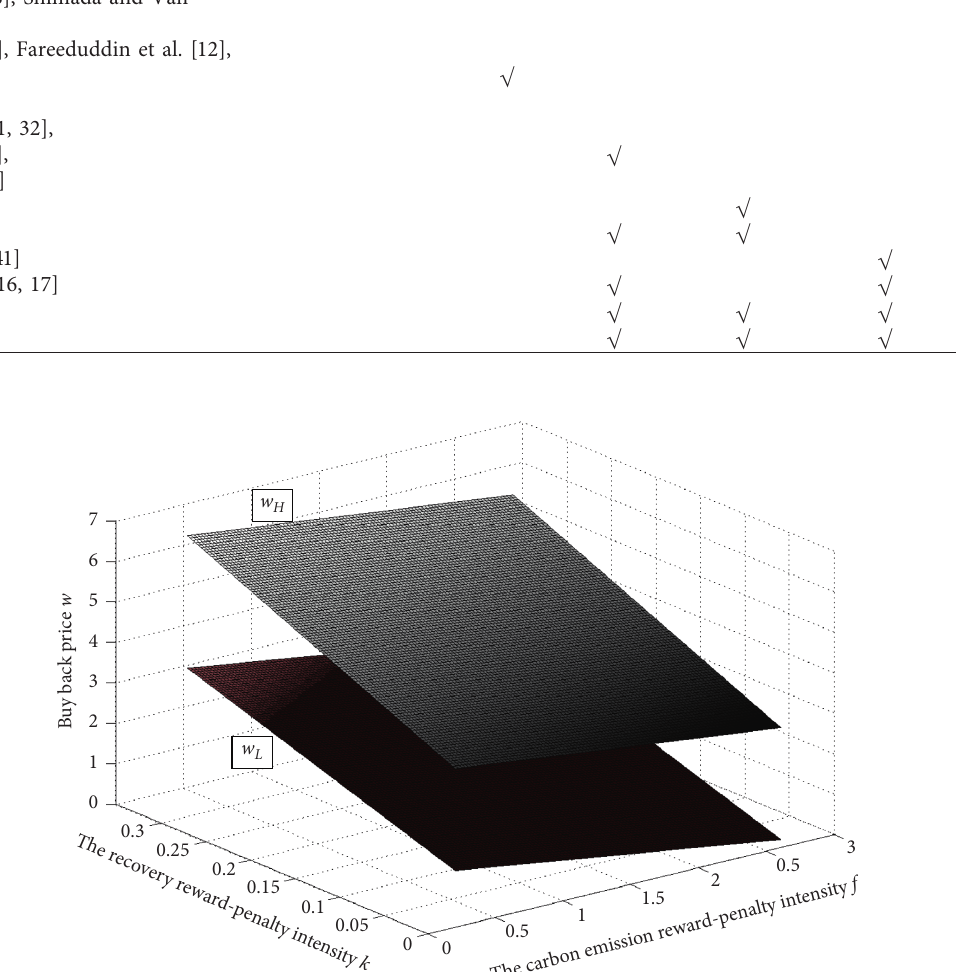
w f and k H and L vs.